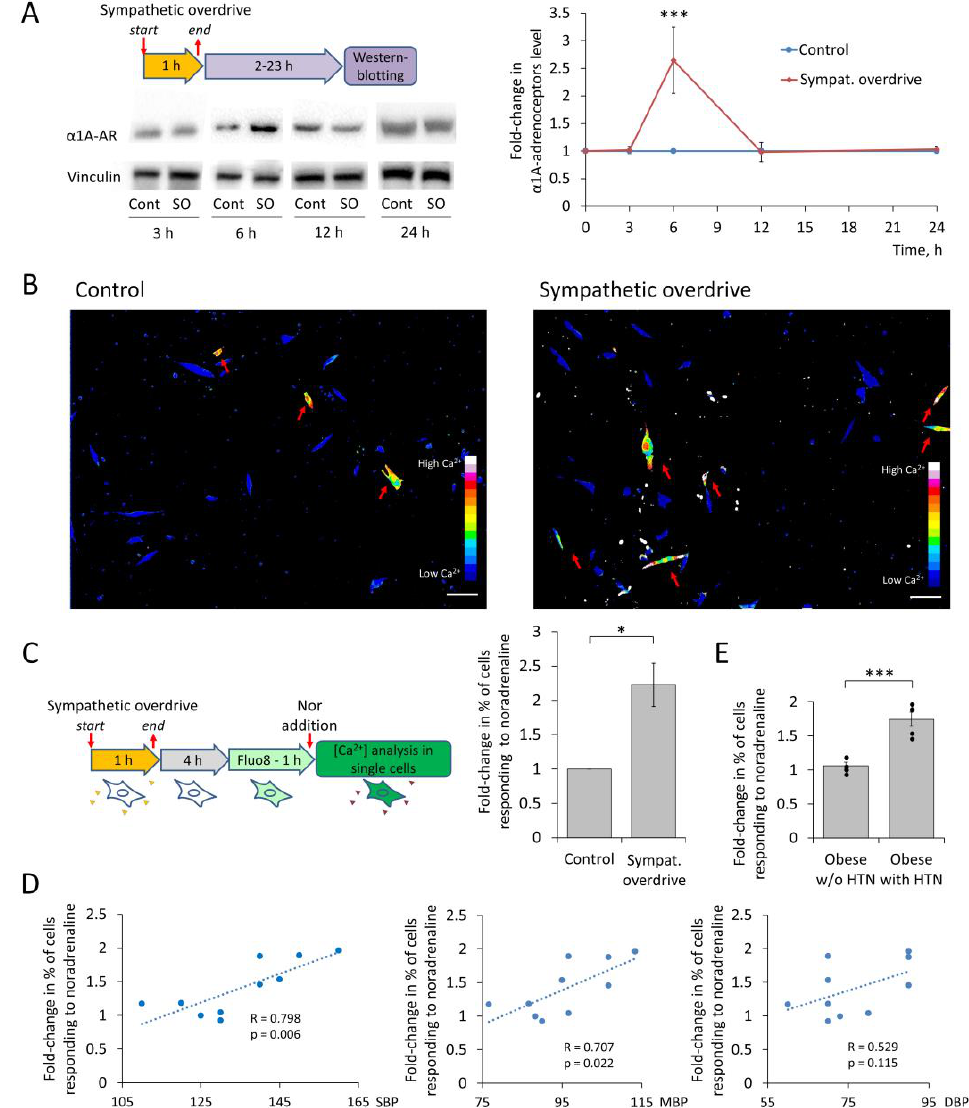
Figure 2. Sympathetic overdrive modeling up-regulates alpha1-adrenoceptor expression and sig- naling on MSCs. ( A ) Western blot analysis of α1A -adrenergic receptors after modeling of